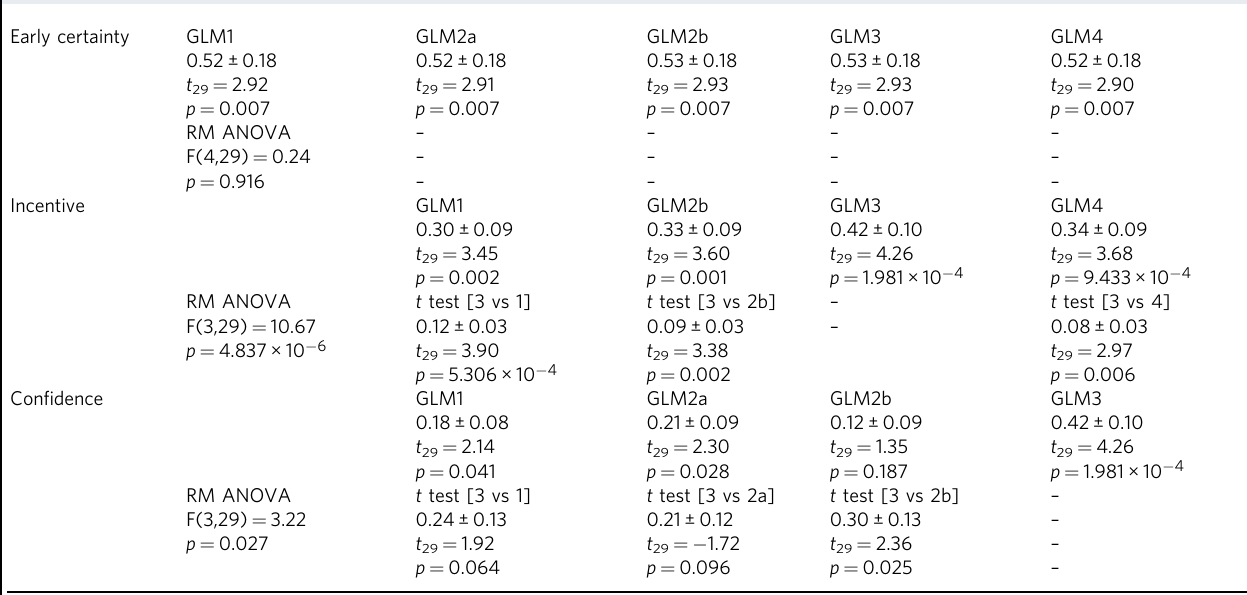
Table 1 Comparison of ventromedial prefrontal cortex (VMPFC) parametric activity ( t values) as a function of model speci fi cation